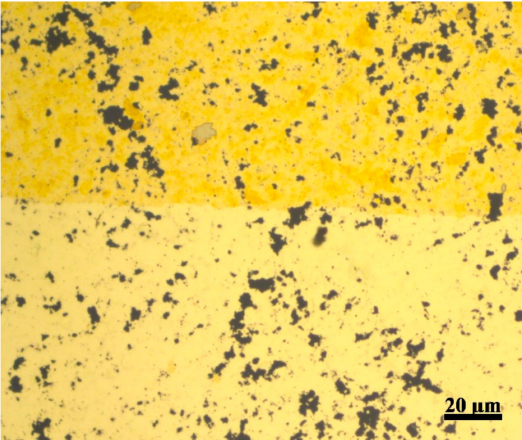
Figure 2. Porous gold film on a COC wafer. The GO layer is removed from the lower side using an adhesive tape.